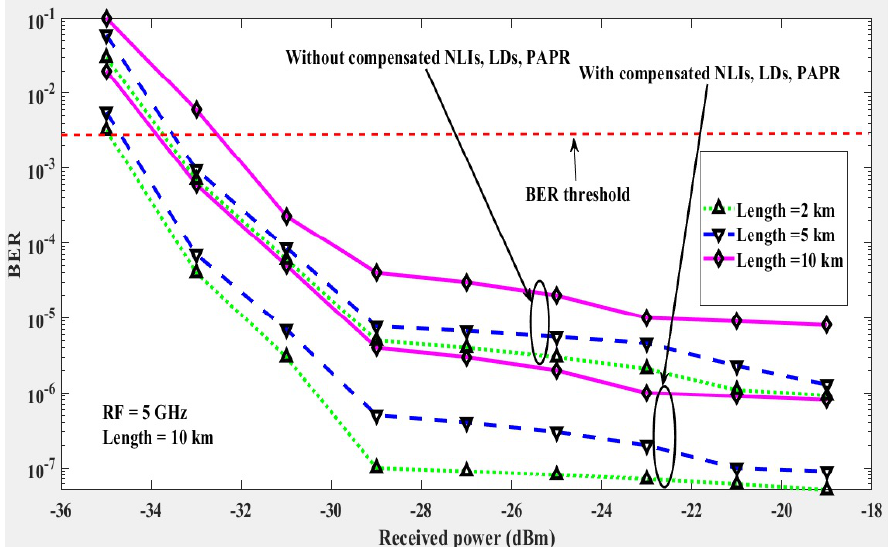
Figure 3. BER with function of received power at 2, 5 and 10 km of optical fiber